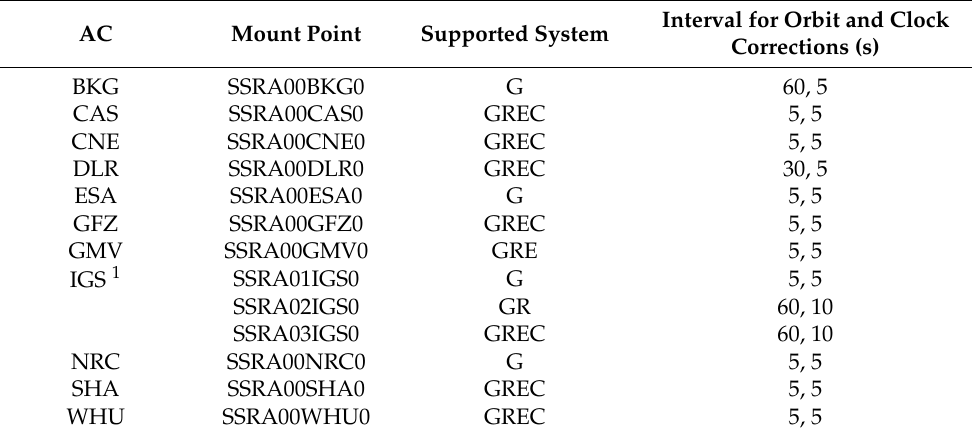
Table 1. Real-time service (RTS) products from different analysis centers